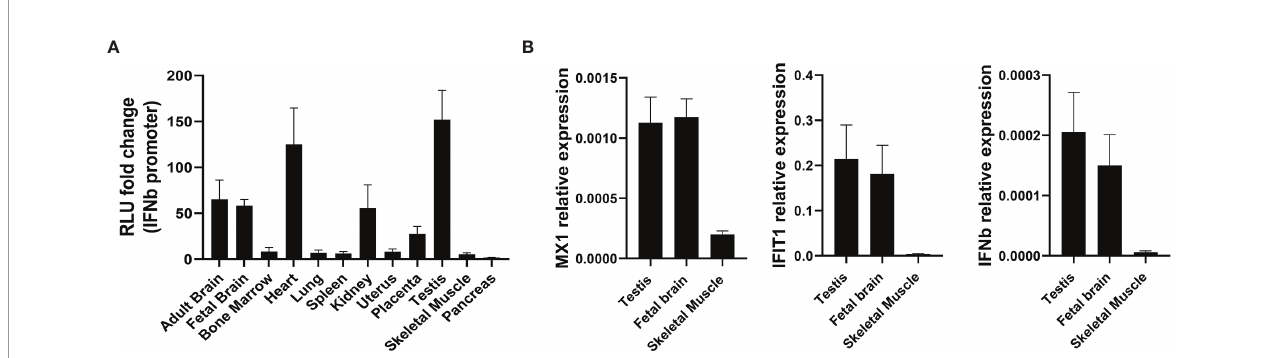
FIGURE 10 | The level of type I IFN pathway activation is tissue-dependent. (A) The IFN b promoter reporter assay was used to assess the immunostimulatory properties of RNA samples from different tissues (n=3). (B) qPCR showing expression of MX1, IFIT1 and IFN b in different tissues from (A) (n=3). Number of replicates indicate biological replicates and data is shown as mean